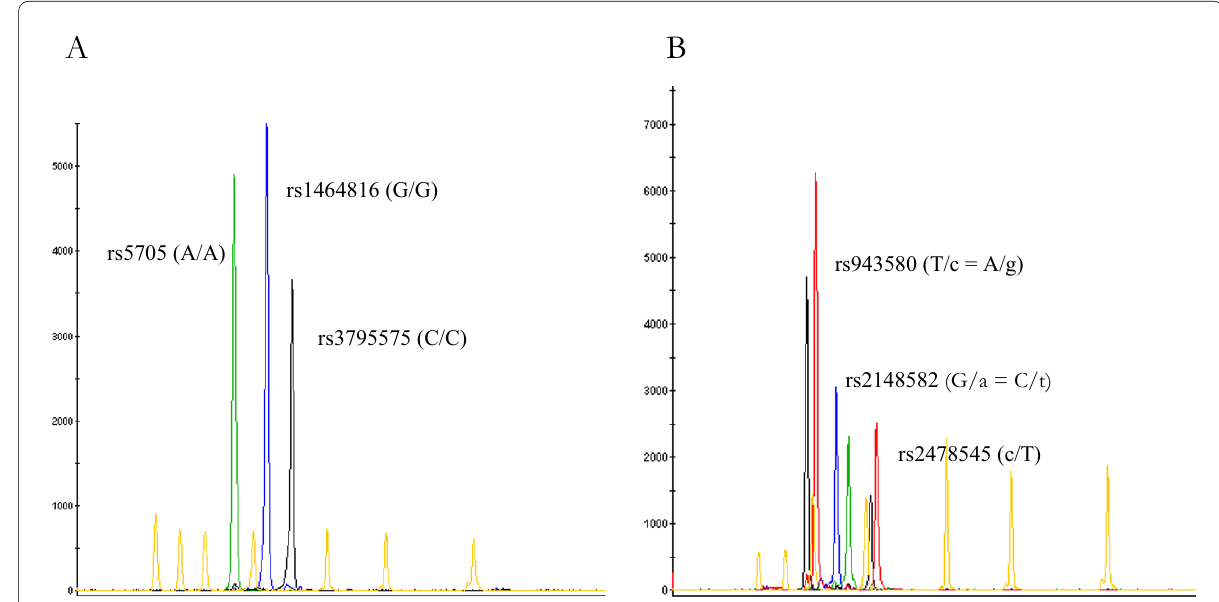
Figure 1 Example of a typical REN (A) and AGT (B) threeplex reaction A. The SNaPshot result of a homozygous carrier of the most common REN haplotype, A-G-C (SNP order: rs5705, rs1464816 and rs3795575). B. The SNaPshot result of a patient carrying both the AGT haplotype C-T-A and hap- lotype t-c-g (SNP order: rs2148582, rs2478545 and rs943580). Lowercase denotes the minor allele at the locus and uppercase the major